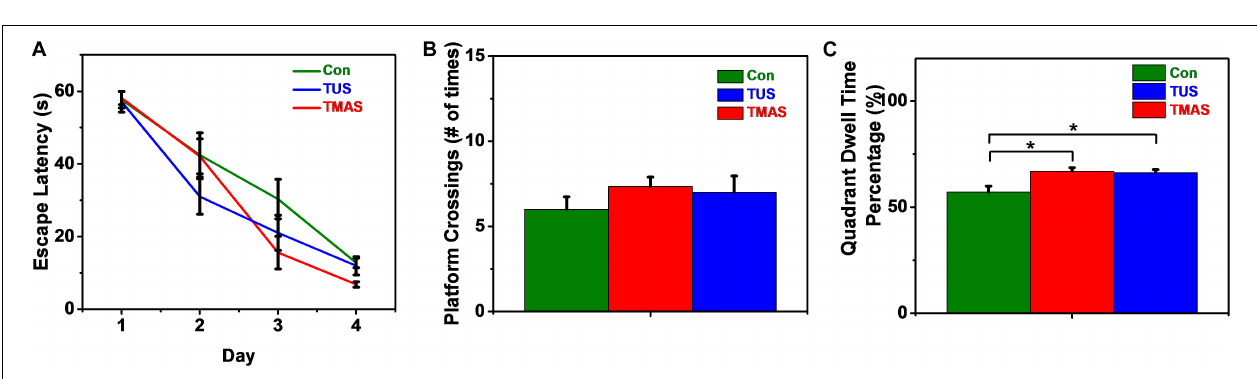
FIGURE 13 | MWM training and test results of the PD mice ( n = 4). (A) Escape latencies during training days. (B) Platform crossings on probing test day. (C) Percentage of duration spent in the target quadrant. ∗ p < 0.05.